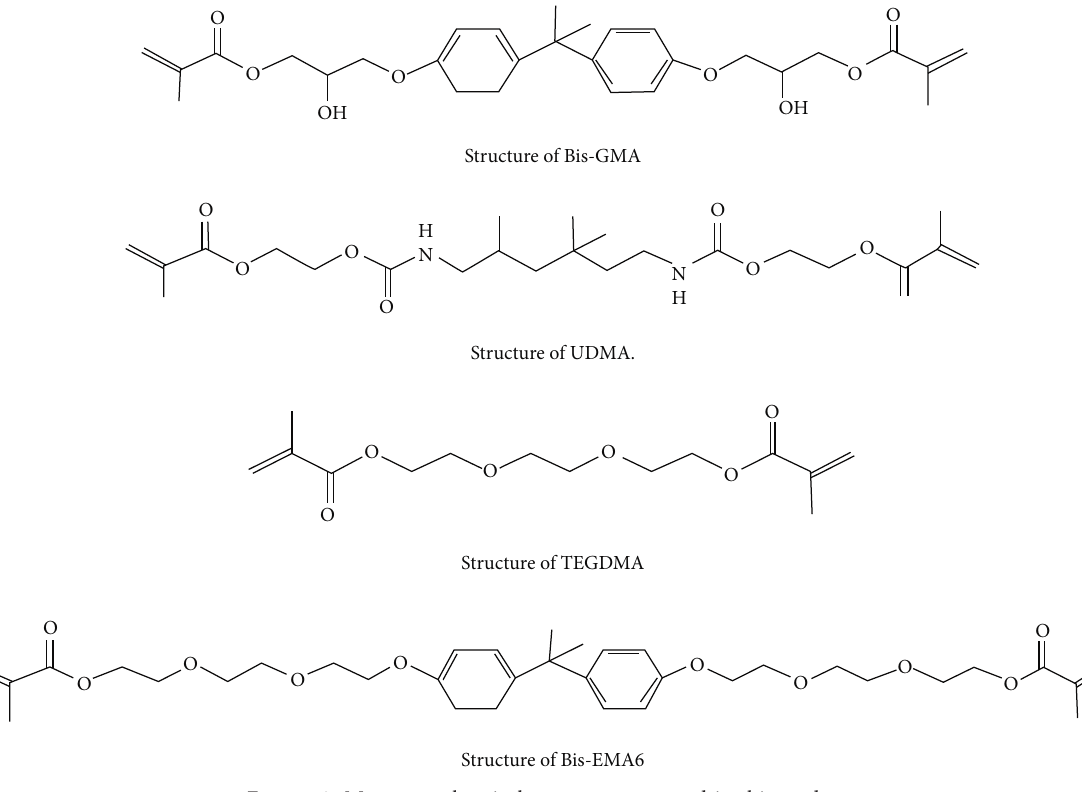
Figure 2: Monomer chemical structure measured in this study. Table 3: Monomers elution in tested groups ( µ